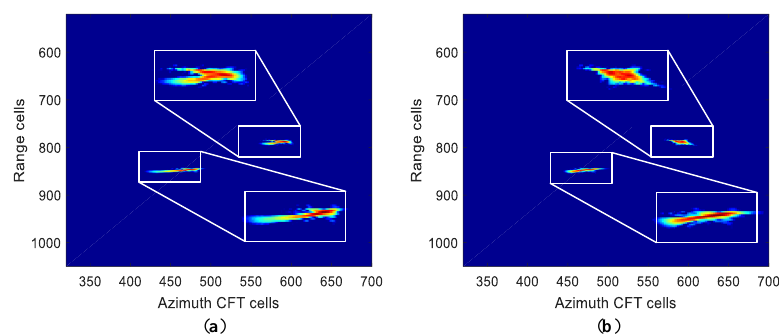
Figure 15. Clutter suppression results. ( a ) Second-order CFT. ( b ) Cubic CFT.